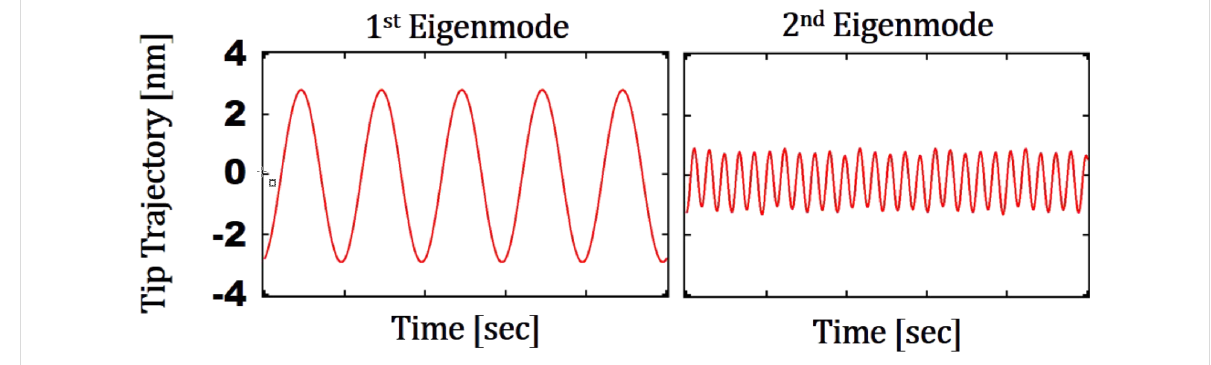
Figure 2: Tip trajectory of a V-shaped cantilever interacting with a Au sample ( L = 85 µm, = 15 µm, b ref = 86 µm, t ref = 0.4 µm, R tip = 9 nm, α = 0°) in time. Left: First eigenmode. Right: Second eigenmode. The setpoint is 60% for the first eigenmode